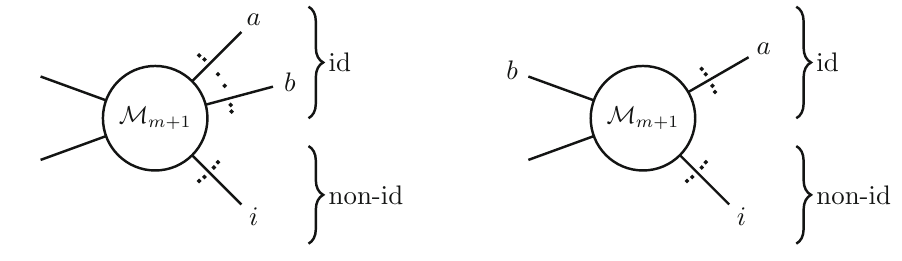
Fig. 3 Labeling for pseudo-dipoles with final-state singularity. Left: identified final-state spectator. Right: initial-state spectator M